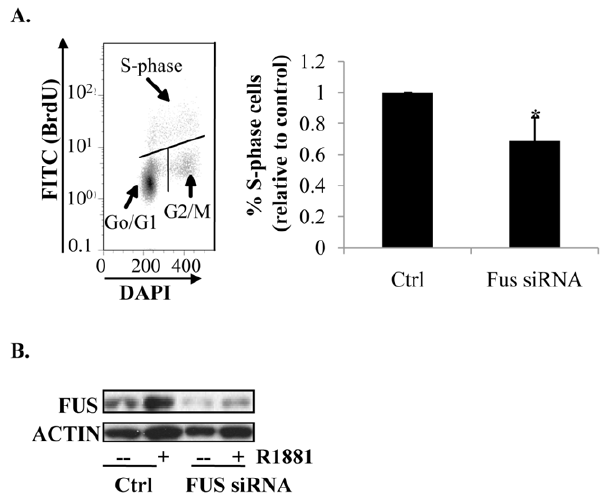
Figure 6. The effects of FUS depletion on proliferation of LNCaP cells. ( A ) Flow cytometric quantification of S-phase cells. siRNA-transfected LNCaP cells were treated with 0.1 nM R1881 for 48 hours. Cells were labelled with BrdU, stained with FITC-conjugated anti-BrdU antibody and DAPI, and subjected to flow cytometry. The graph on the right represents quantification S-phase cells as a ratio to the respective controls. *P , 0.05, n=3. ( B ) Levels of FUS protein in cells treated with FUS siRNA. Western blot analysis of levels of FUS and loading control actin corresponding to the samples whose cell-cycle profile is plotted in